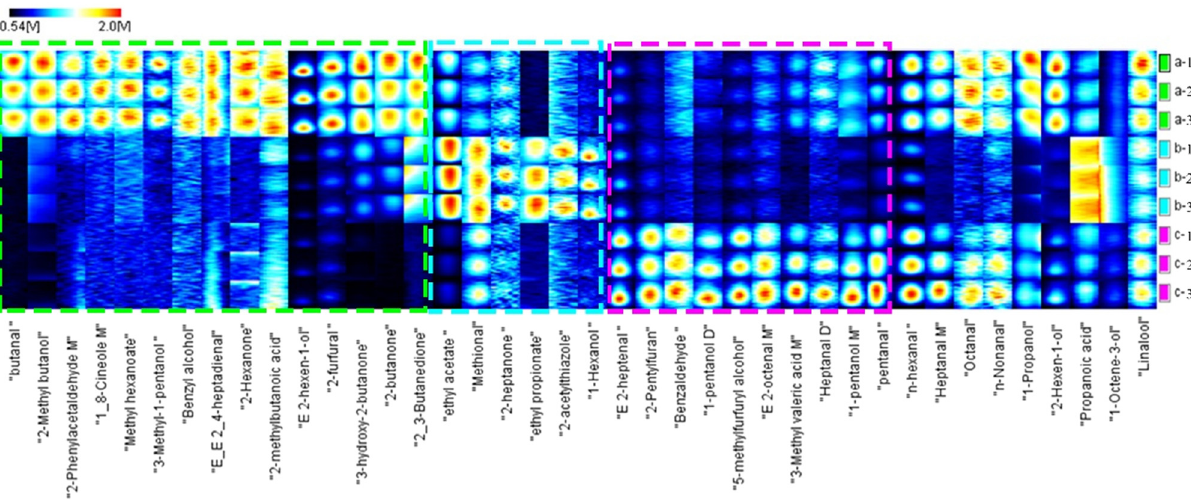
Figure 5: Fingerprint spectra of VOCs of avocado oil in di ff erent extraction methods: ( a ) squeezing extracted; ( b ) supercritical carbon dioxide extracted; ( c ) aqueous extracted. The color indicated the concentration of the compound, white indicated the concentration, and red indicated the higher